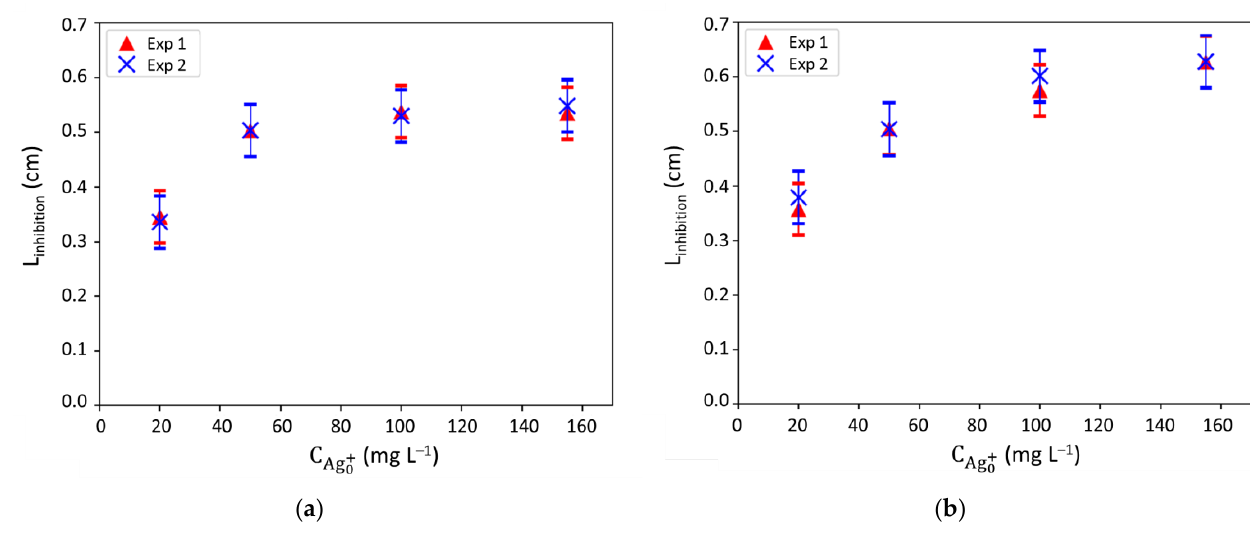
Figure 9. Inhibition halos radii (L inhibition ) measured after 24 h of contact with silver ions (Ag + ) on: ( a ) LB agar and ( b ) agar with similar composition of LB except that NaCl was removed; different initial concentrations of Ag + were tested and each condition was replicated (Experiment 1 and Experiment 2, named Exp 1 and Exp 2, respectively).